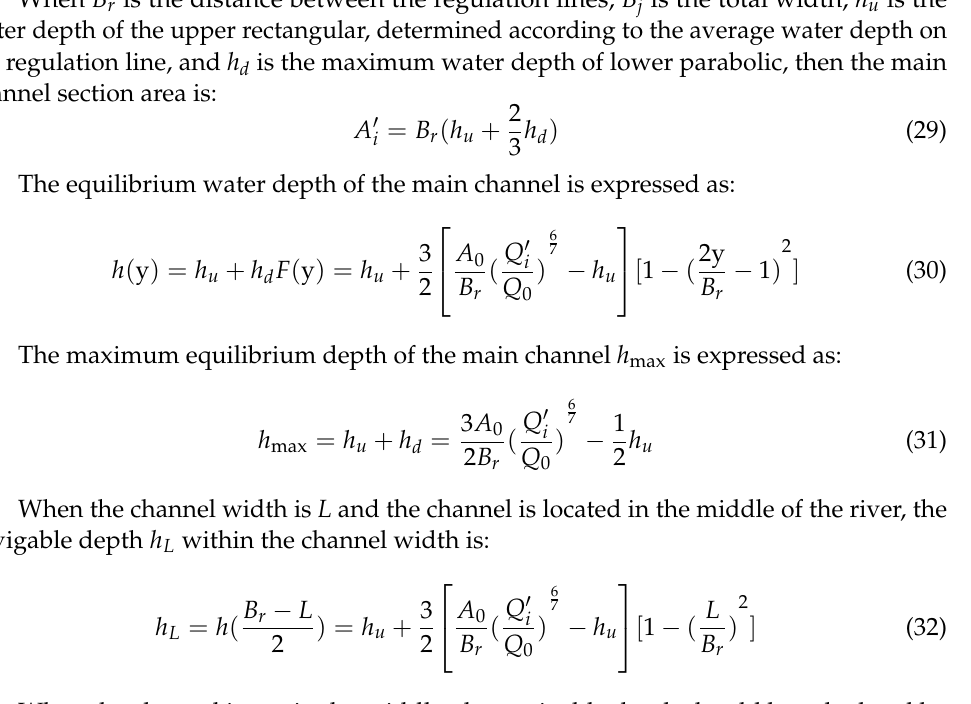
Figure 4. Generalization of cross-section with spur dikes.